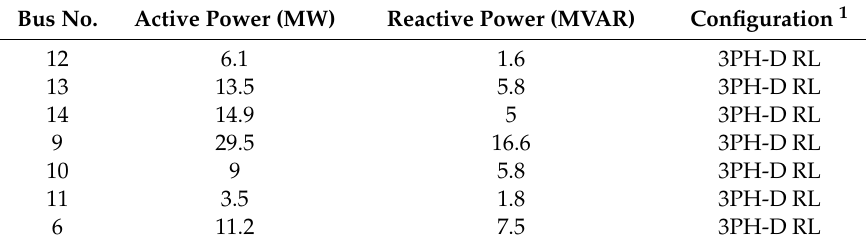
Table 5. System load parameters.